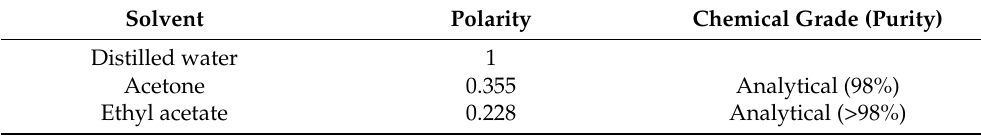
Table 1. Relative polarity of the solvents